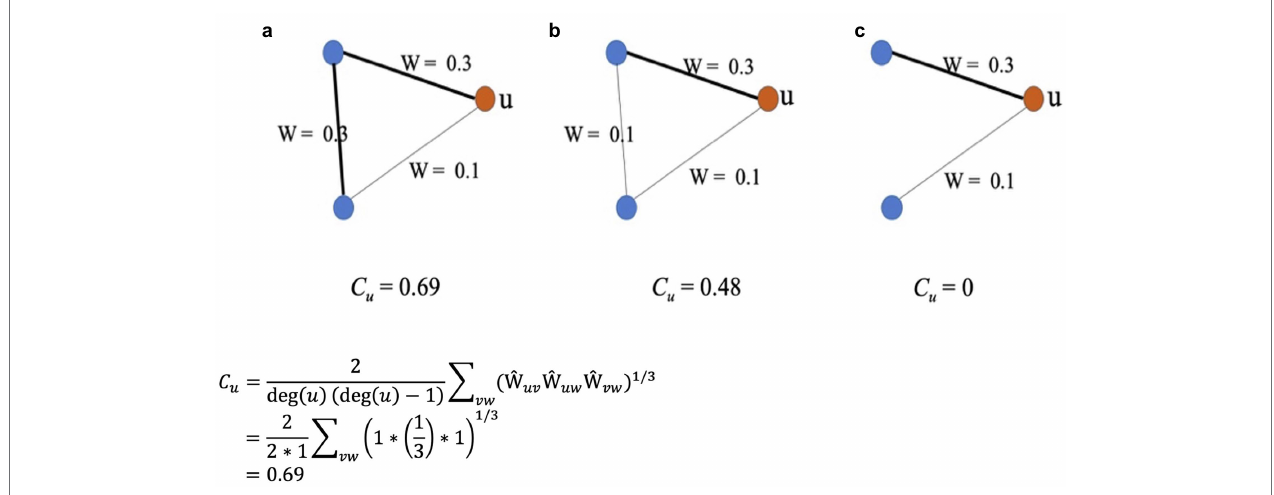
FIGURE 2 | An illustration of the clustering coefficient, C u , of a node u in three different weighted networks: a, b, and c. The three networks have an equal number of nodes but differ in edge weights. Also shown is the detailed calculation of C u for network